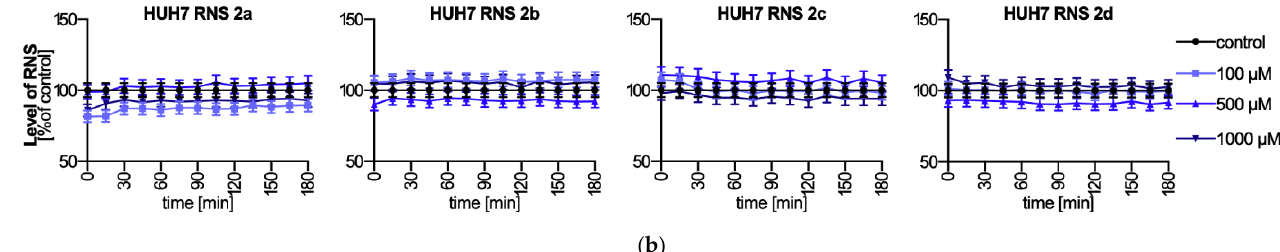
Figure 7. Comparison of changes in ( a ) ROS and ( b ) RNS levels in HUH7 cells treated with three different concentrations (100, 500 and 1000 μ M) of 2a – 2d for 0–180 min compared to ROS and RNS levels in a control sample (100%). ROS and RNS formation were tested overtime, in the range of 0–180 min after the adding of the tested compounds. Results are presented as mean ± SD from three independent experiments. The significance of differences was estimated based on multifactor ANOVA and post-hoc Tukey tests. Statistical analysis for ROS level: HepG2+2a: p < 0.05: control vs. 60 min (100, 500 and 1000 μ M); control vs. 90 min (100 μ M); p < 0.01: control vs. 135–150 min (500 μ M); p < 0.001 control vs. 0–45 min (100, 500 and 1000 μ M); control vs. 105–180 min (100 μ M); control vs. 165–180 min (500 μ M); HepG2+2b: p < 0.001: control vs. 0–180 min (100, 500 and 1000 μ M); HepG2+2c: p < 0.05: control vs. 0–30 min (500 μ M); HepG2+2d: p < 0.01: control vs. 0–120 min (100 and 1000 μ M). Statistical analysis for RNS level: HepG2+2a: p < 0.01: control vs. 0–45 min (100 μ M). For more experimental details please see “Materials and Methods”.